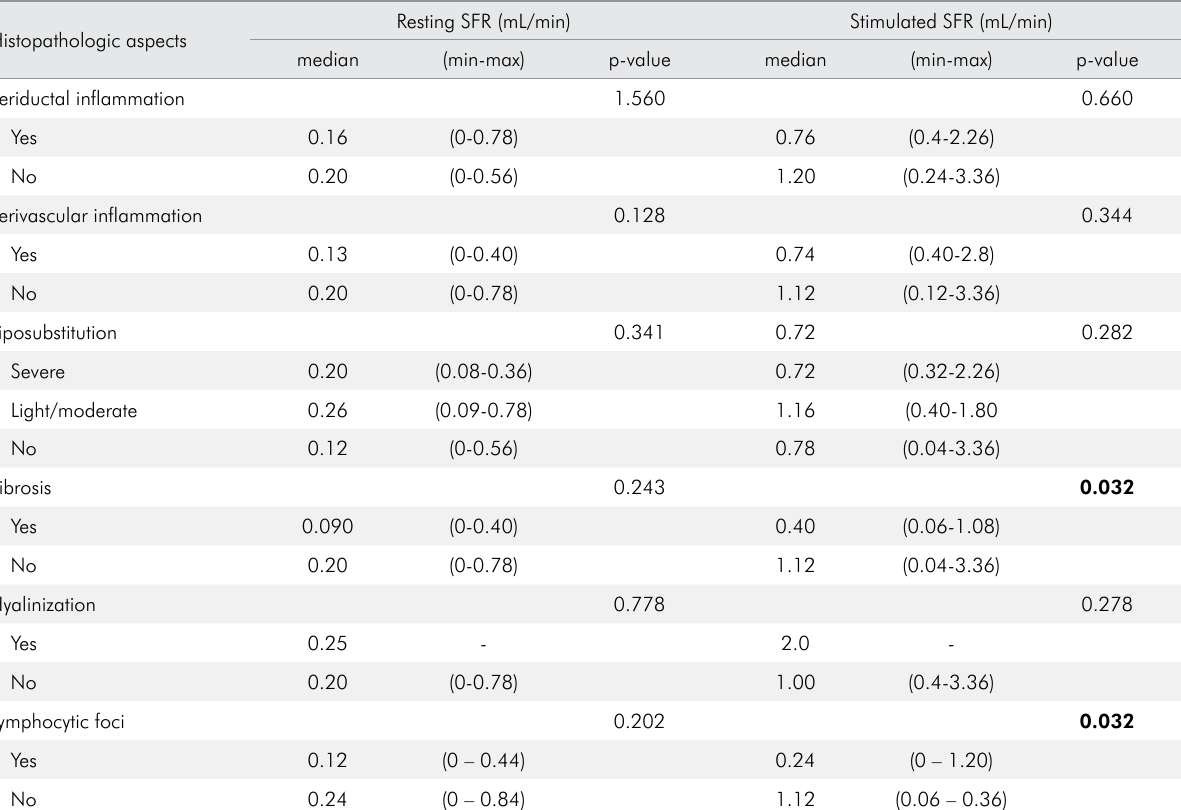
Table 2. Salivary flow rates according to histopathologic aspects of minor salivary gland of the 51 subjects with rheumatoid arthritis in the